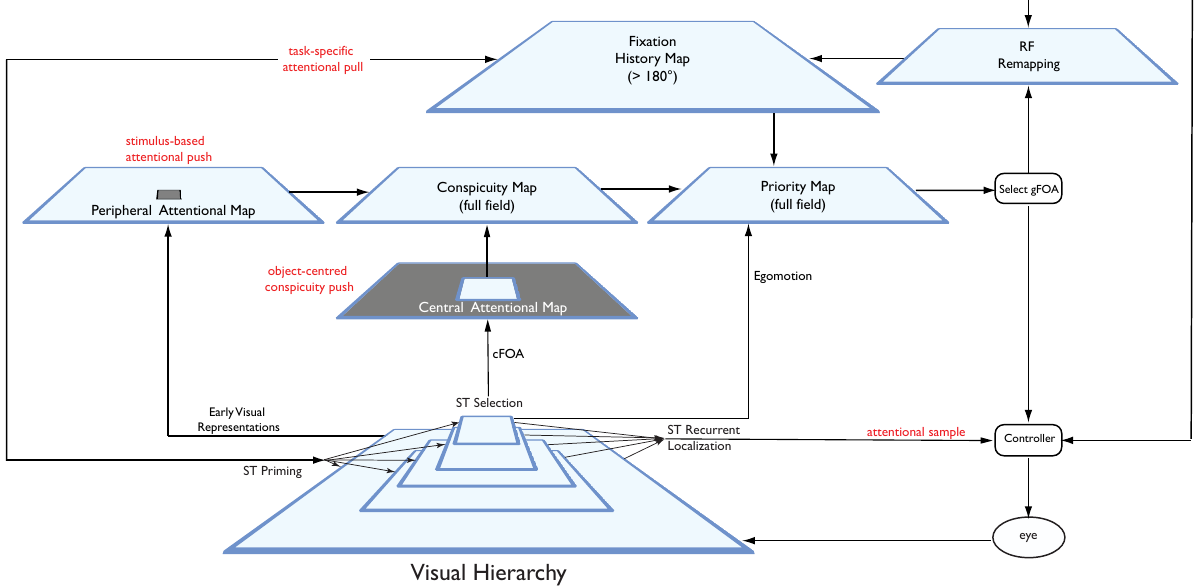
Figure 10. The fixation control strategy of STAR. See text for explanations of the components